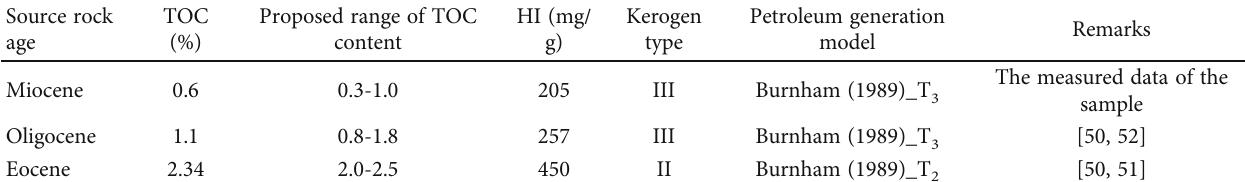
Table 3: Geochemical parameters of source rocks in the study area [50 –